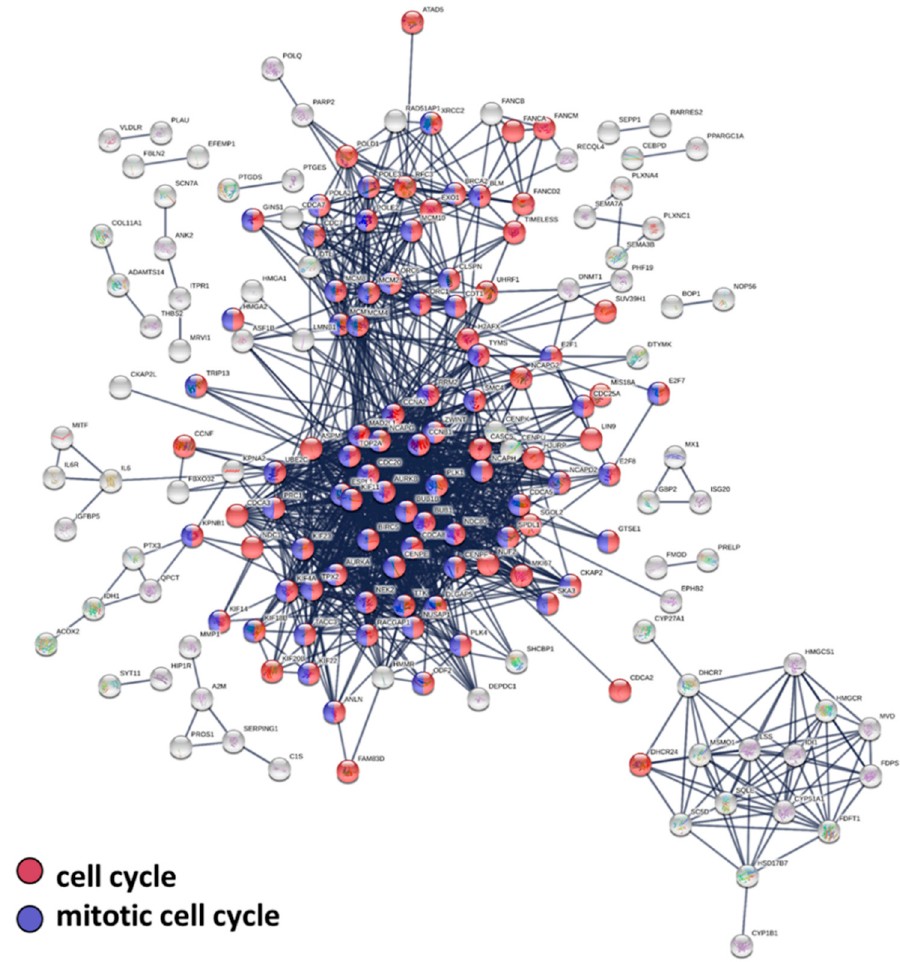
Figure 4. Protein–protein interaction network analysis of dysregulated genes in nintedanib-treated IPF fibroblasts using STRING. The 308 top dysregulated genes (157 upregulated and 151 downregulated) were entered into the Search Tool for the Retrieval of Interacting Genes (STRING) database for protein–protein interaction (PPI) network analysis. The minimum required interaction score was set to the highest confidence (score = 0.900). Nodes without edges are not displayed. This analysis obtained a highly interactive PPI network of 307 nodes and 1227 edges, with PPI enrichment p value of <1.0 × 10 − 16 . Most genes in the PPI network were related to the following biological pathways: cell cycle (110 genes, shown in red), cell cycle process (94 genes), mitotic cell cycle process (76 genes), and mitotic cell cycle (78 genes, shown in blue). Nodes represent proteins and edges represent protein–protein associations.